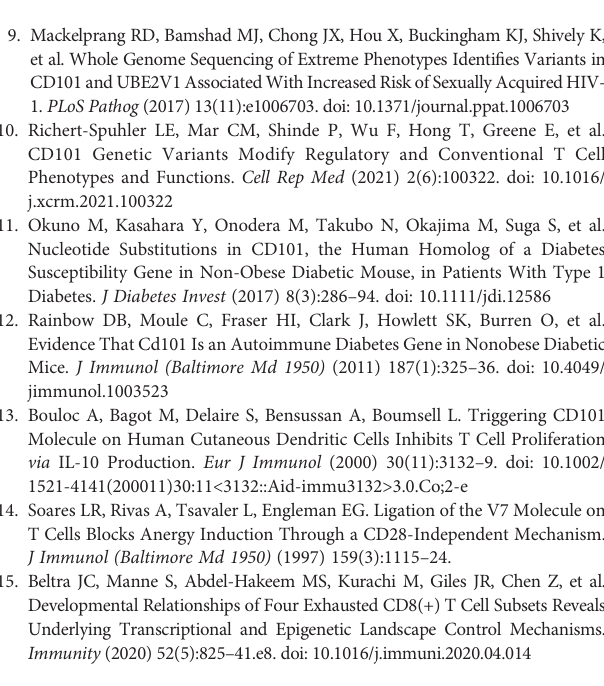
Supplementary Figure 1 | Prognostic value of immune cell in fi ltration in GEPIA2021 database. (A) Survival curves of Macrophage M2 was shown for OS. (B) Survival curves of T cell CD4+ memory resting was shown for OS. Supplementary Figure 2 | Analysis of CD101 expression based on cell type groups. (A) Cell proportion analysis between M2 and T cell regulatory in glioma based GEPIA2021 database. (B) CD101 expression level analysis between M2 and T cell regulatory in glioma based GEPIA2021 database. Supplementary Table 1 | Clinical information of 14 glioma